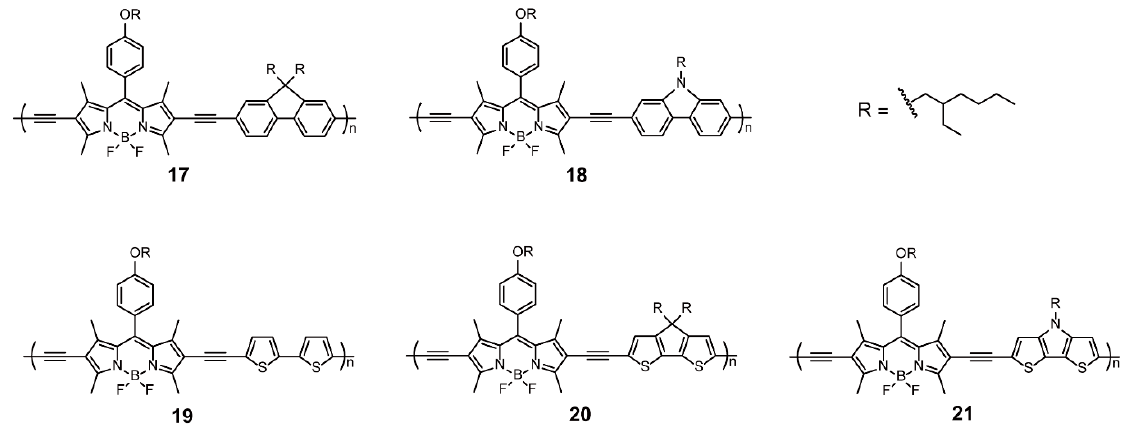
Figure 6. Chemical structures of polymers 17–21 ( Reproduced with permission from Reference [48]. Copyright @ 2012,